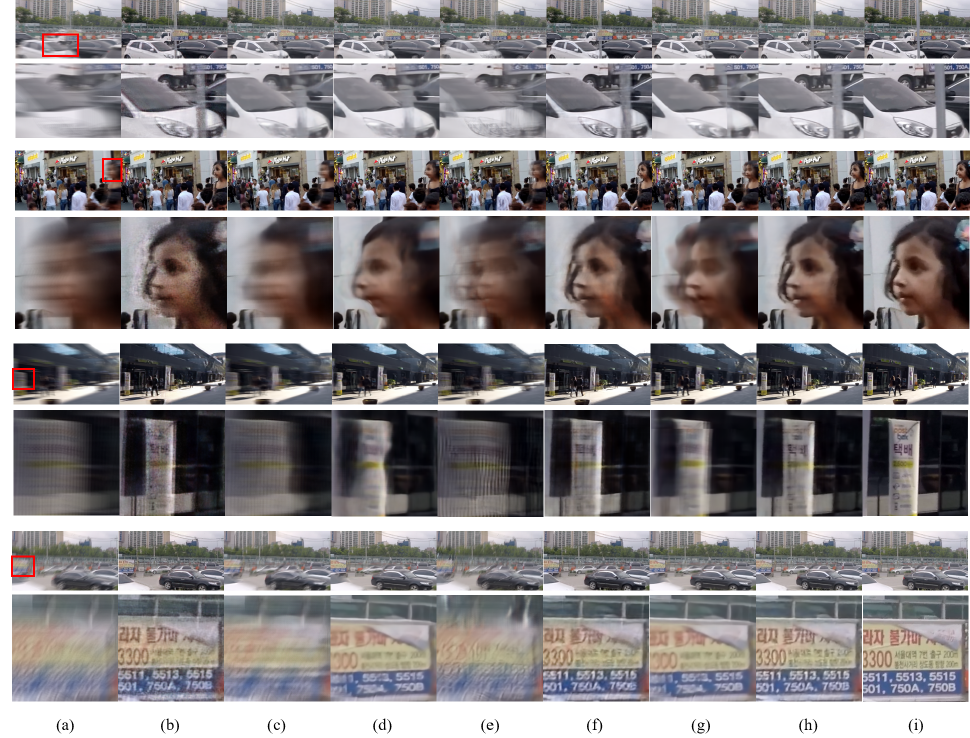
Figure 6. Qualitative comparison of the results using the GoPro synthetic dataset. ( a ) Input blurred image. ( b ) E2VID [21]. ( c ) STFAN [5]. ( d ) CDVD-TSP [8]. ( e ) ESTRNN [10]. ( f ) LEDVDI [12]. ( g ) D 2 Net [13]. ( h ) Proposed MEVDNet. ( i ) Ground